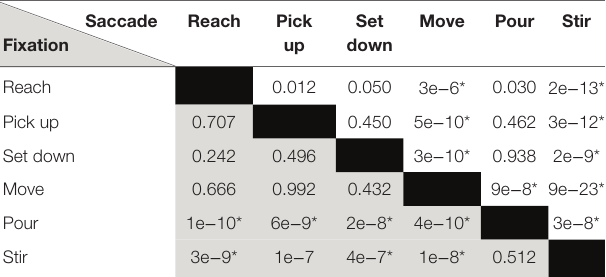
Asterisks indicate the t-tests that were statistically significant for a Bonferroni-corrected α= 0.003